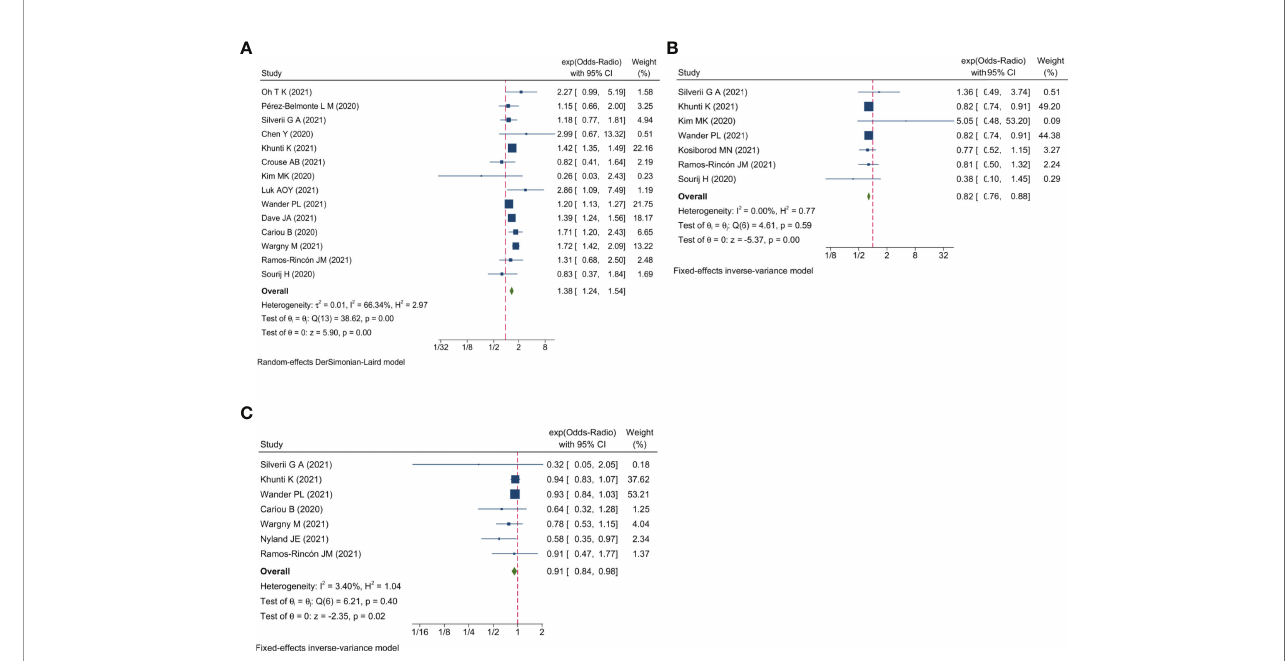
FIGURE 3 | Forest plot showing the association between antidiabetic agents use and mortality. (A) Insulin; (B) SGLT2i; (C) GLP1RA.